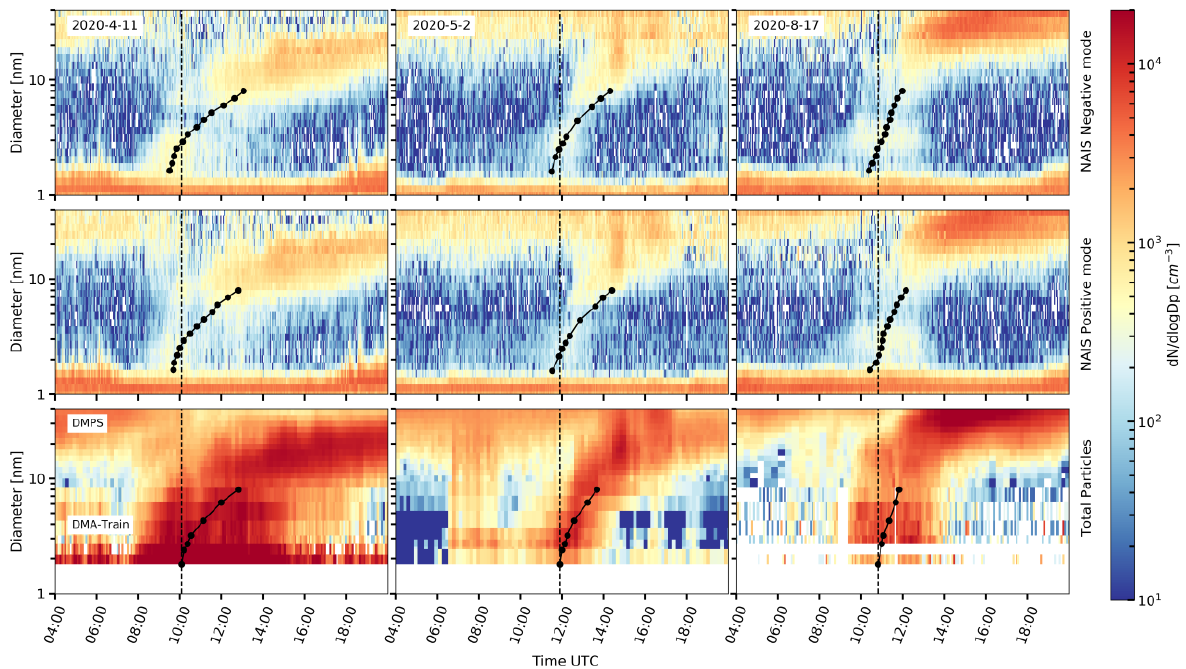
Figure 3. Evolution of the ion-size distribution (first and second row) measured with the NAIS and the combined total (neutral plus charged) size distribution measured with the DMA-train and the twin-DMPS during three characteristic events. The maximum diameter detected by the DMPS is cut off at 40nm to have an easier comparison with the ion-size distribution range of the NAIS. The black points represent the maximum concentration times for the different mobility diameters used to calculate the growth rate in the sub-10nm size range (see Fig. S3 for example fits of the maximum concentration time at